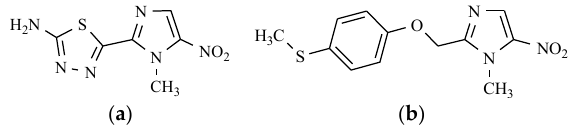
Figure 17. 5-Nitroimidazoles as antiprotozoal drugs: ( a ) Megazol; and ( b )